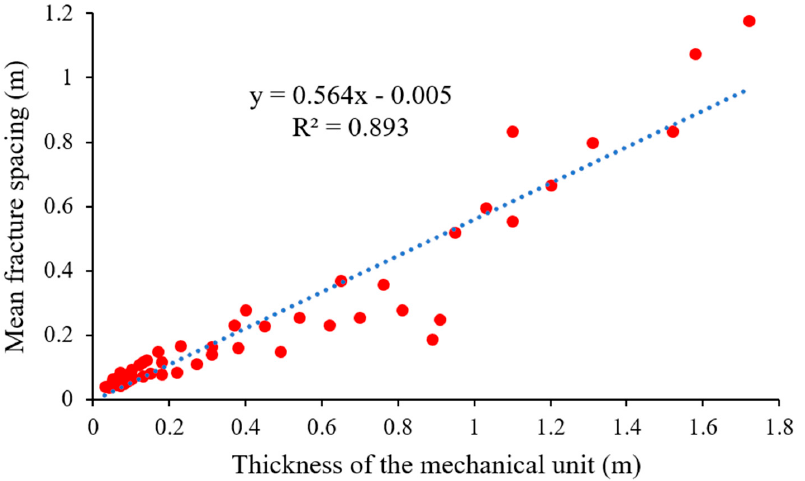
Figure 16. The relationship between the mean fracture spacing and the thickness of mechanical units from 52 data points on outcrops.